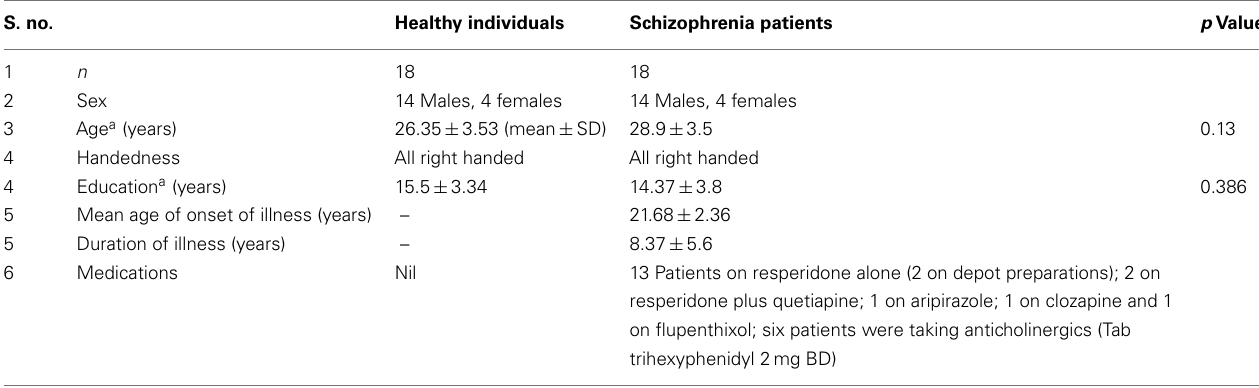
Table 1 | Demographic and clinical characteristics of